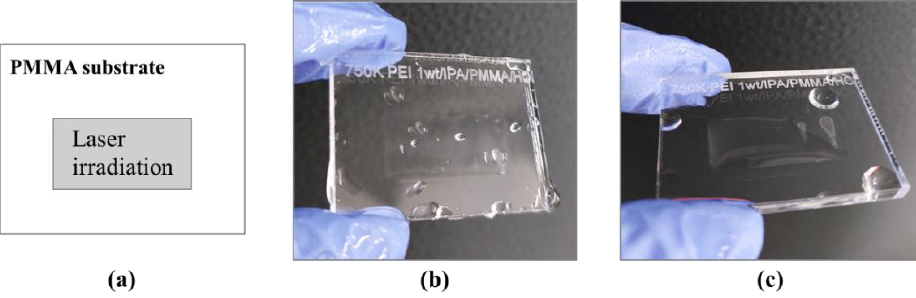
Figure 7. Surface wettability test. The schematic of the sample ( a ) and pictures after rinsing with water on the laser-treated bare PMMA ( b ) and PEI-grafted PMMA ( c ). Table 4. Contact angles for laser-treated bare PMMA and PEI-grafted PMMA a